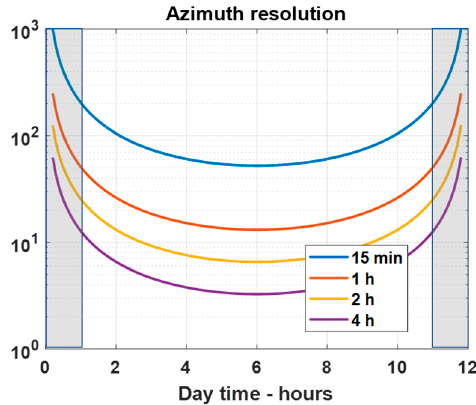
Figure 9. Azimuth resolution achievable by an X band GEO-SAR with the maximum allowed eccentricity of 0.002 [14], as function of the hour of the day since the perigee pass (t = 0), computed for different subapertures. The shaded areas mark times when bad performance is achieved: It is recommended that they match the periodical peaks in Figure 7.